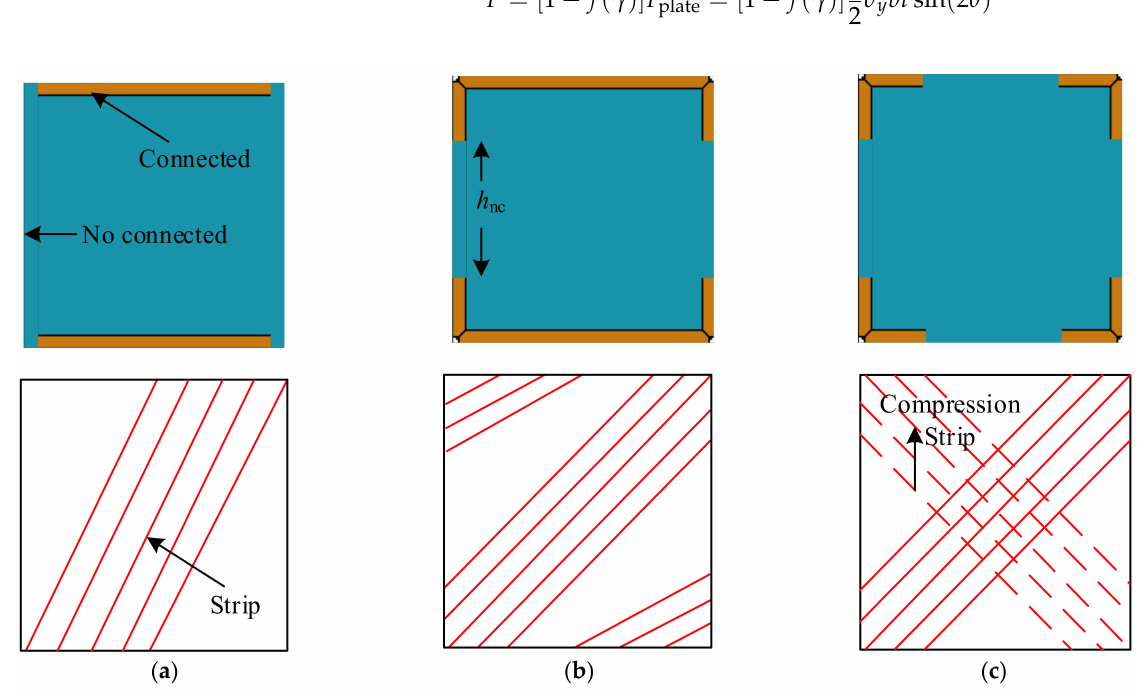
Figure 3. Simplified mechanical model for PC-SPSW: ( a ) Only beam connection; ( b ) Partially column connection; ( c ) Four-corner connection.